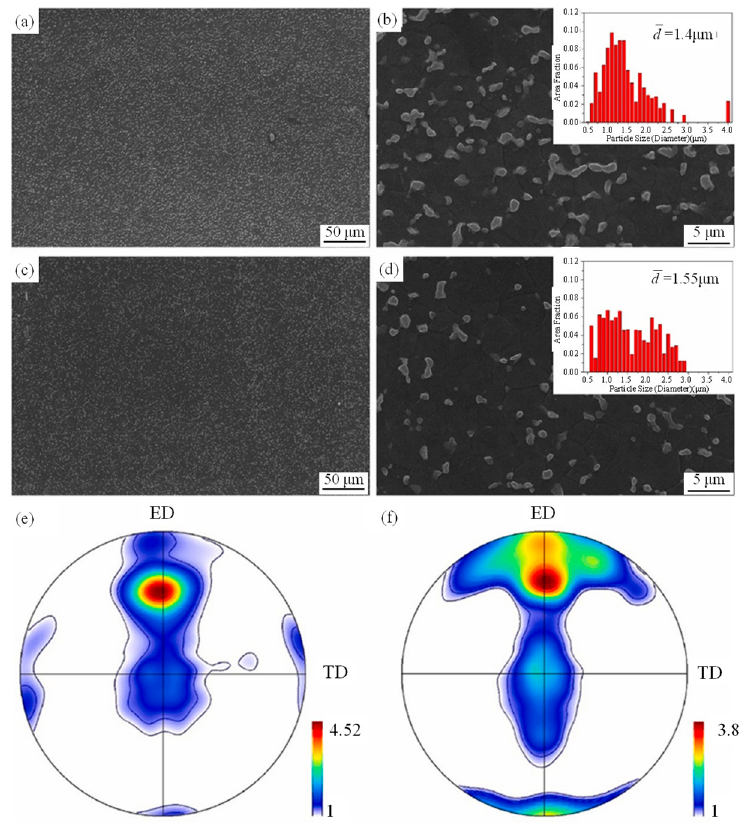
Figure 20. SEM images after different passes of ECAP and (0002) pole figures [120]: ( a , b , e ) four passes; ( c , d , f ) twelve passes. Reproduced with permission from Elsevier B.V.